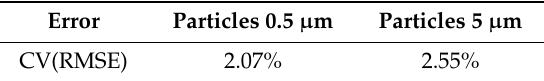
Table 7. Simulation error during the tests.